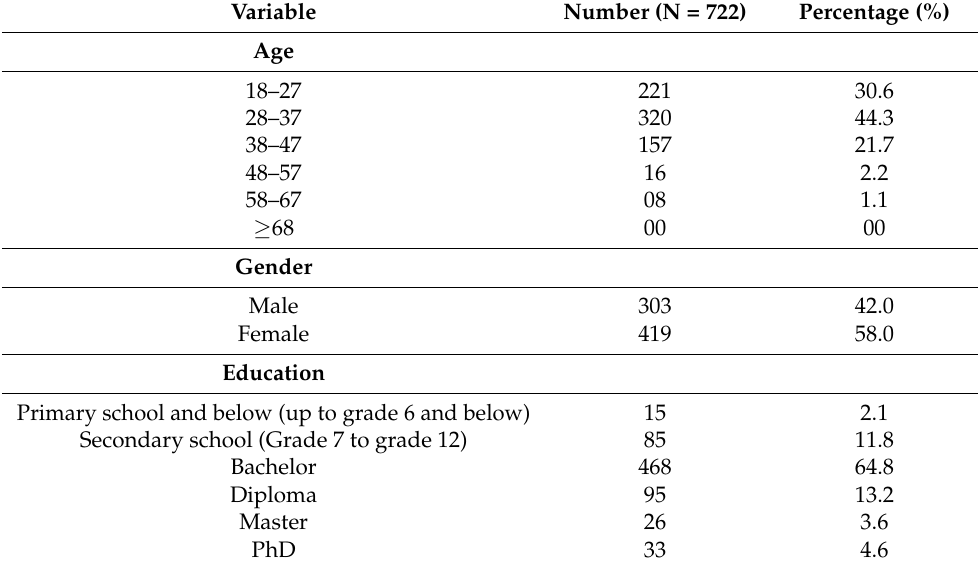
Table 1. Summary of the demographic